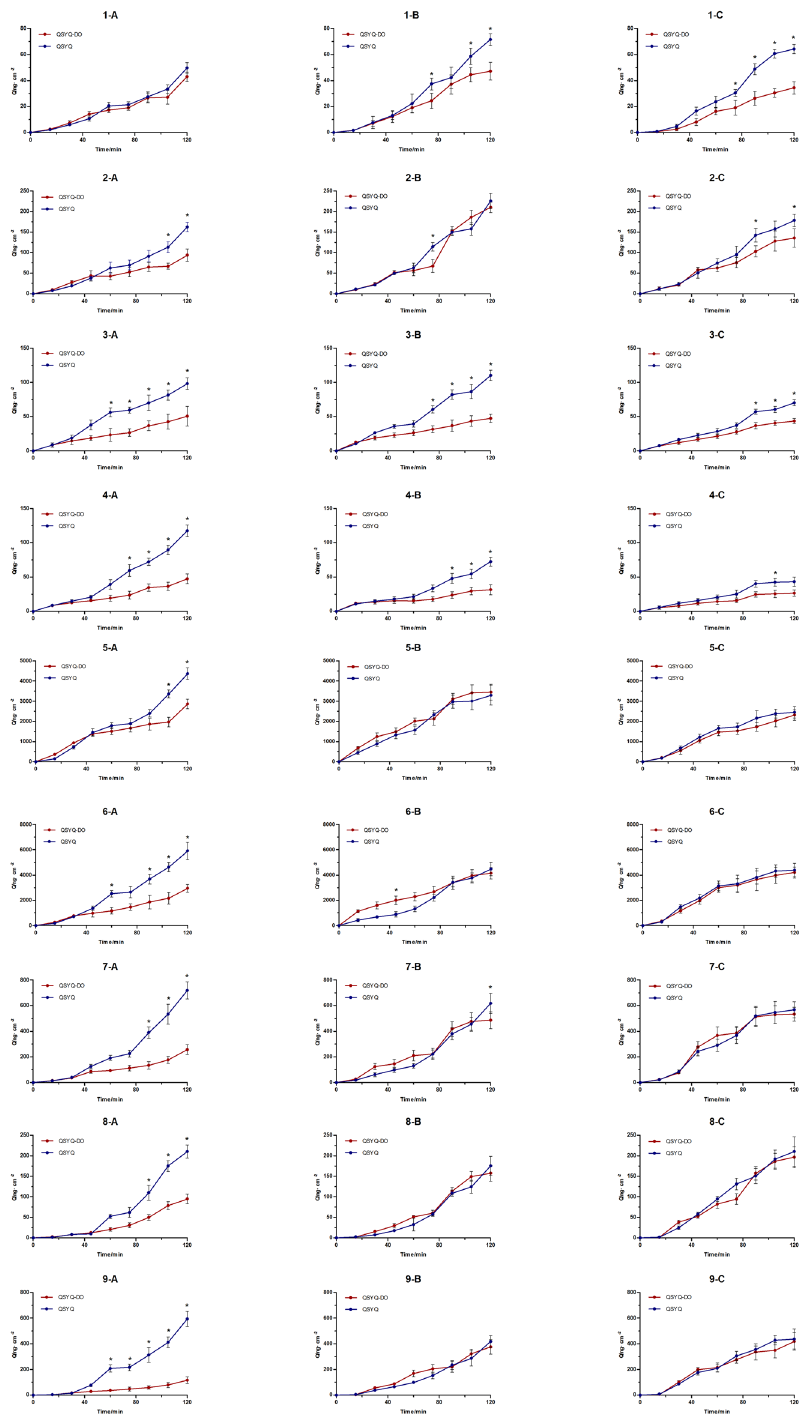
Figure 4. Accumulative absorption of major ingredients from QSYQ and QSYQ-DO by different intestinal segments. ( A ) Duodenum, ( B ) Jejunum, ( C ) Ileum. Compound label: 1. Formononetin, 2. Calycosin, 3. Ononin, 4. Calycosin-7-O-b-D-glycoside, 5. Protocatechuic aldehyde, 6. Tanshinol, 7. Rosmarinic acid, 8. Salvianolic acid B, and 9. Astragaloside IV. Data are expressed as mean ± SD, n = 3, * p < 0.05, ** p < 0.01 vs . QSYQ-DO